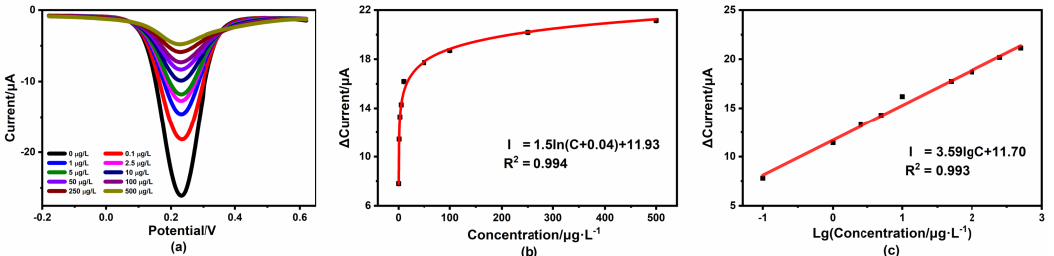
Figure 8. DPV measurements for different Hg 2+ concentrations. ( a ) DPV plots; ( b ) the relationship between the peak current change and Hg 2+ concentration; ( c ) calibration curve for peak current change vs. the logarithm of Hg 2+ concentration.